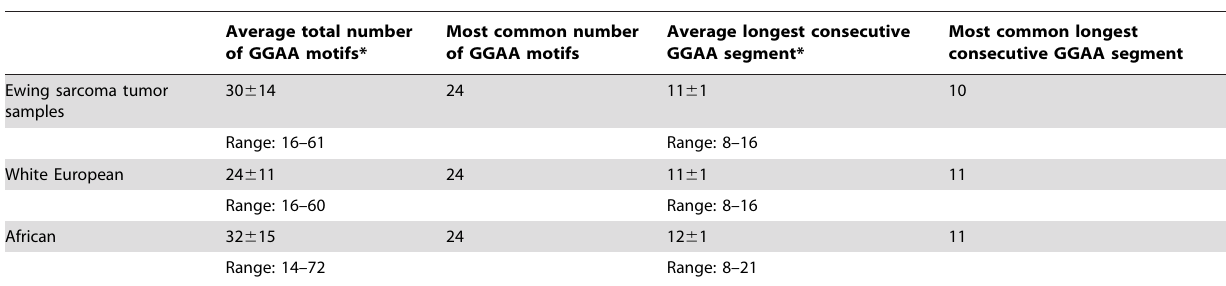
Table 2. NR0B1 GGAA-microsatellite sequence characteristics in Ewing sarcoma tumors and healthy controls.